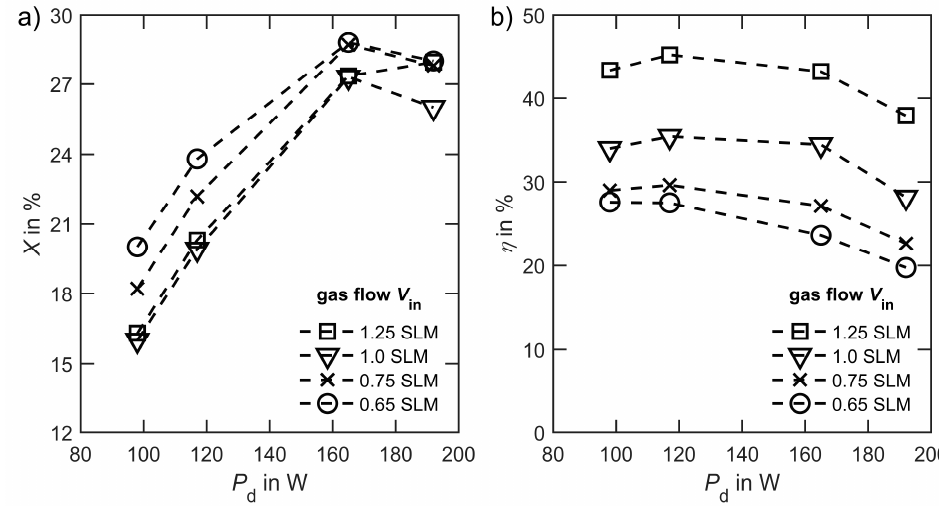
Figure 2. Performance of the reactor at different gas flow rates V in and discharge power P d . In ( a ), the conversion X is shown while ( b ) displays energy efficiency 𝜂 .